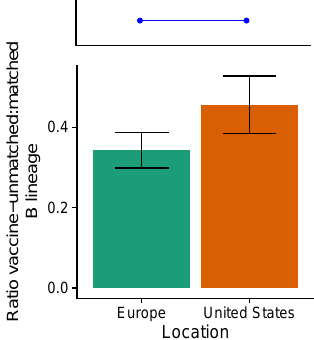
Figure 4. The ratios of vaccine-unmatched to matched B lineages differ marginally between the United States and Europe from the 2009–2010 to the 2012–2013 seasons ( p = 0.05). The blue line and points show the expectation of no spatial difference in lineage ratios under the assumption that VE does not differ between lineages. Error bars indicate 95% binomial confidence intervals. Unweighted seasonal lineage frequencies are shown in Figure